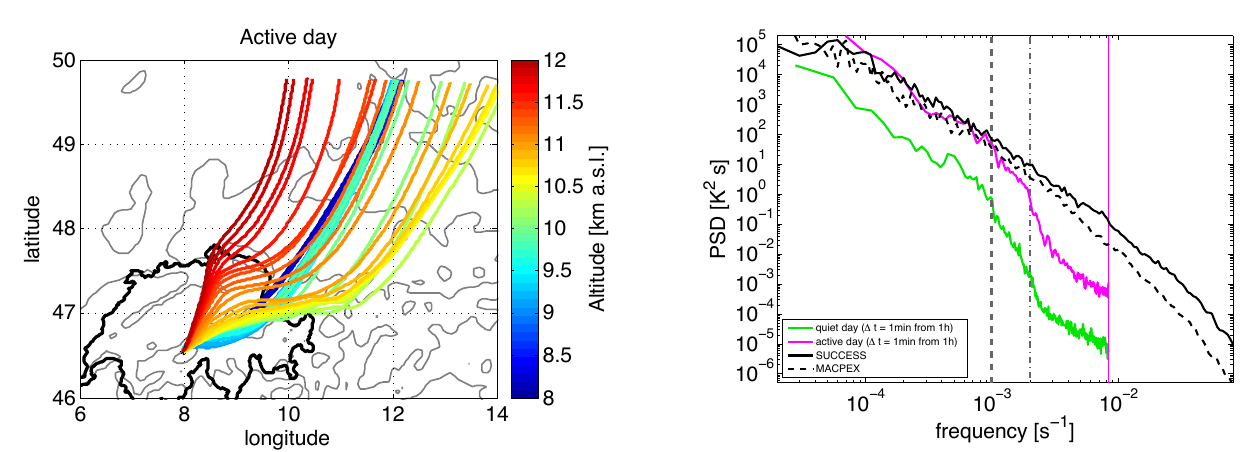
Figure A1. Path of the trajectories arriving at Jungfraujoch on 12 March 2012 at 03:00UTC.